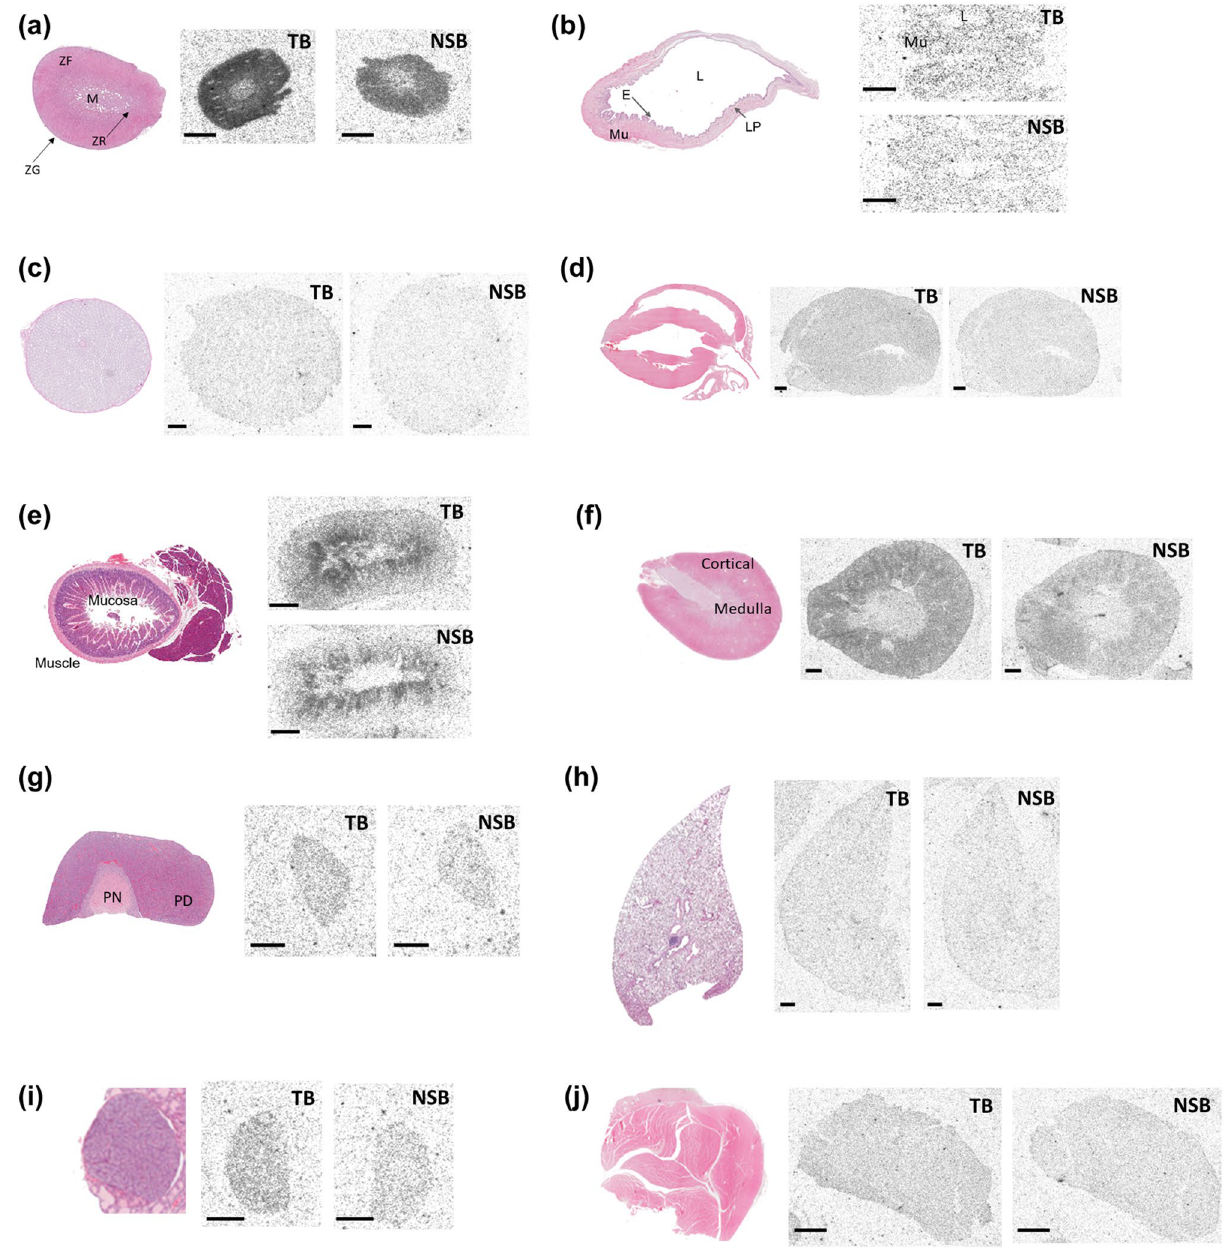
Figure 5. Distribution of [ 3 H]-EMPA binding sites in rat peripheral tissue sections. Representative images from hematoxylin–eosin staining and OX2R autoradiography in rat peripheral tissues are shown. All samples were collected at approximately the same time (ZT2–3). Non-specific binding (NSB) was analyzed in the presence of 1 µM JNJ-10397049. Total binding (TB) and NSB in different rat peripheral tissues: adrenal gland ( a ), urinary bladder ( b ), testis ( c ), heart ( d ), gut ( e ), kidney ( f ), pituitary ( g ), lung ( h ), thyroid ( i ), and skeletal muscle ( j ). Scale bar represents 1 mm. M medulla, ZF zona fasciculate, ZR zona reticularis, ZG zona glomerulosa, L lumen, Mu muscle, E epithelium, LP lamina propria, PN pars nervosa, PD pars